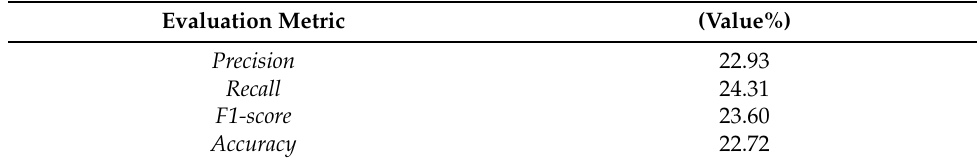
Figure 5. Training curve for binary classification. Table 6. Evaluation for 14 categories classification on the UCF-Crime dataset.